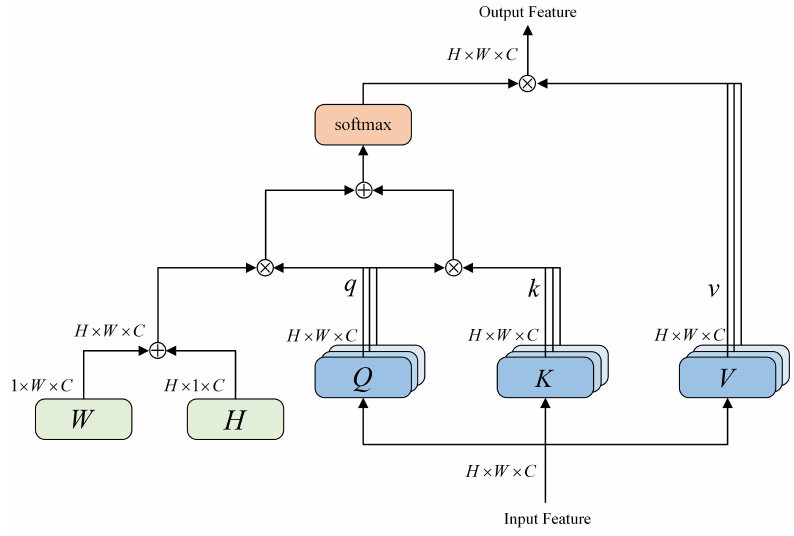
Figure 4. The improved multi-head self-attention mechanism with two-dimensional relative posi- tion